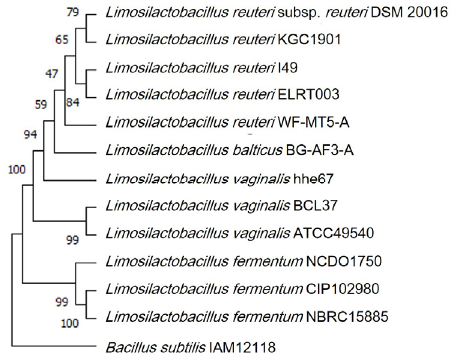
Figure 1. The phylogenetic tree is based on the 16s rRNA gene sequence data obtained from the NCBI database, showing the phylogenetic positions of L. reuteri KGC1901. The tree was constructed using the maximum likelihood algorithm and Kimura 2-parameter model and the numbers displayed next to the branch indicate bootstrap values (500 replicates). Bacillus subtilis was used as an outgroup. Phylogenetic analysis was conducted in MEGA11 (Molecular Evolutionary Genetics Analysis)